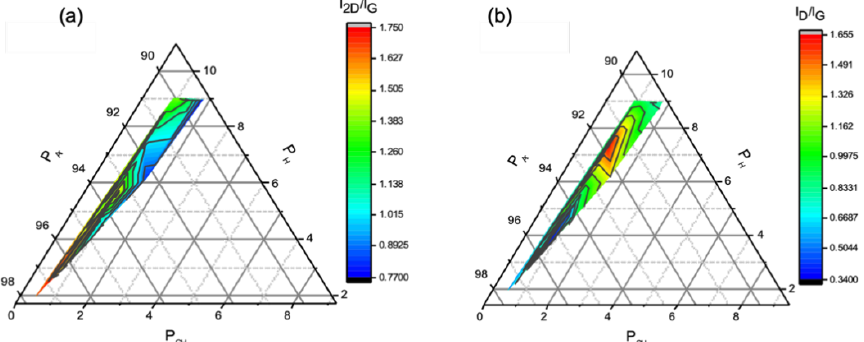
Figure 5. Ternary plots showing Raman intensity ratios as a function of gas partial pressures (P H2 , P Ar and P CH4 ), ( a ) I 2D /I G and ( b ) I D /I G (All axes are normalised with respect to total gas pressure).